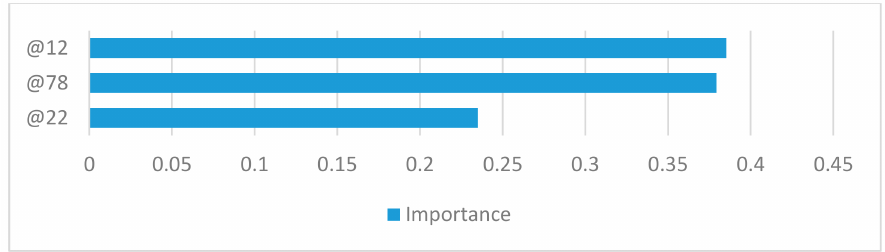
Figure 11. The orders of importance given by the artificial neural network. Legend: (22) = the number of people per household (person/household), (78) = the ratio of employmentseekers (%), (12) the ratio of those 60 years and older within the permanent population (%), (47) = The amount of electricity provided to households (1000 kWh/household) ( n = 46).